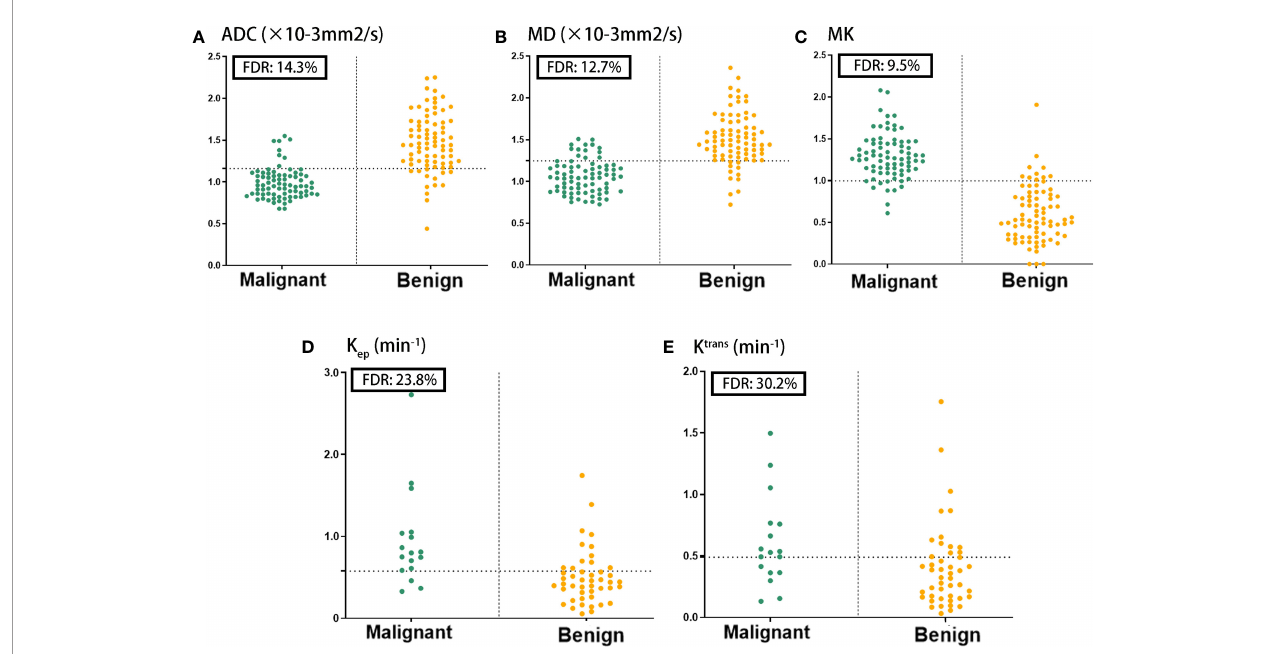
FIGURE 3 | Comparison of the false diagnosis rate (FDR) for ADC (A) , MD (B) , MK (C) , K ep (D) and K trans (E) parameters in differentiating between benign and malignant breast